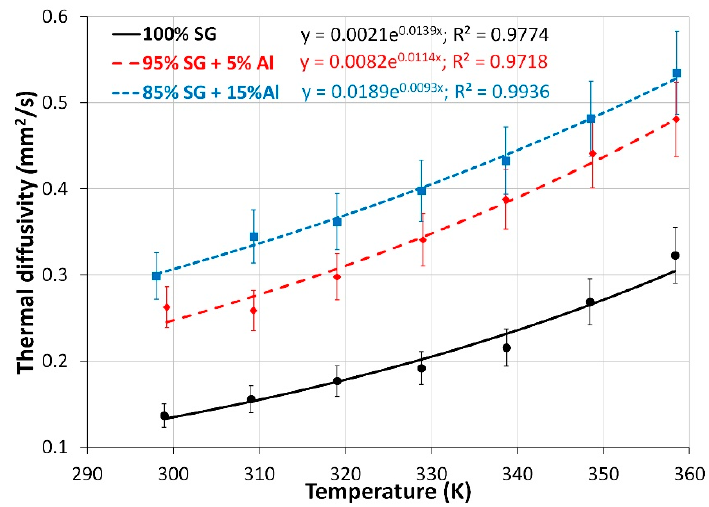
Figure 5. Effect of the Al additives on thermal diffusivity of the SG-based adsorption bed.